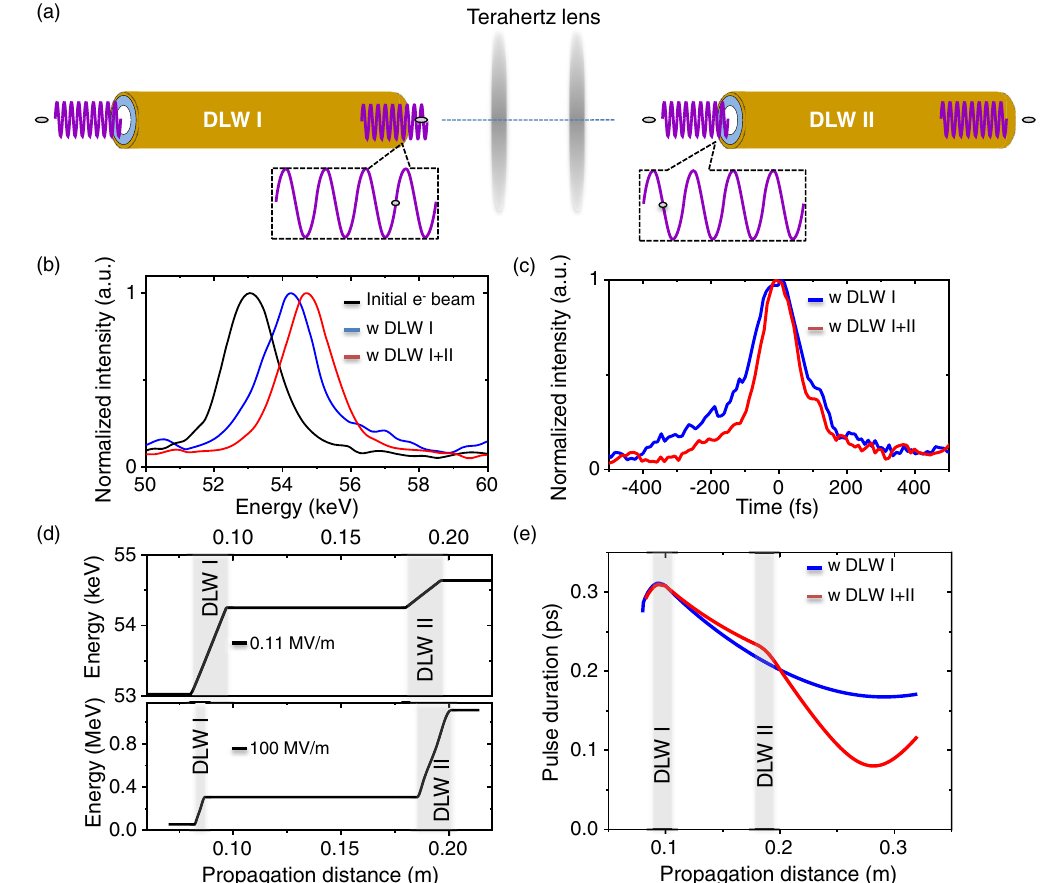
FIG. 4. Cascaded manipulation. (a) Schematic of the cascaded acceleration. Because of the low group velocity of the accelerating THz field inside the DLW, after THz-electron interaction, the electrons overtake the THz wave at the exit of DLW I. In a vacuum, the THz pulse catch up and overtake the electron bunch again before both enter DLW II for a second interaction, i.e., acceleration stage. (b) Measured electron energy spectra for the input beam (black curve), single-stage accelerated beam (blue curve), and cascaded electron acceleration (red curve). (c) Measured pulse duration via the single-stage compression (blue curve) and two-stage compression (red curve). (d) Top: Simulation of the experimental condition with two-stage cascaded acceleration that couples 20 nJ THz pulses with 0 . 11 MV = m longitudinal electric fields into the DLW I. The THz coupling efficiency from the first to second stage is approximately 10%. Bottom: Simulation of two-stage cascaded acceleration with approximately 100 MV = m field gradients inside the DLW I and approximately 90% THz coupling from DLW I to DLW II. (e) Simulation of the electron pulse duration (FWHM) during propagation with a single DLW stage and two DLW stages. The coupling of THz into the second stage is assumed to be approximately 10%. The simulation is performed with ASTRA with around 1 fC charge injected into the DLW corresponding to the experimental